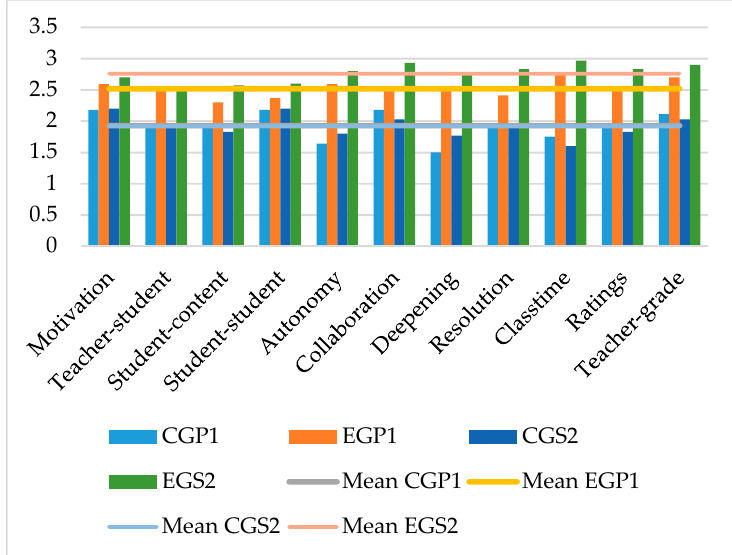
Figure 1. Comparison between control group primary education (CGP 1 ), control group secondary education (CGP 2 ), experimental group primary education (EGP 1 ), experimental group secondary education (EGP 2 ).